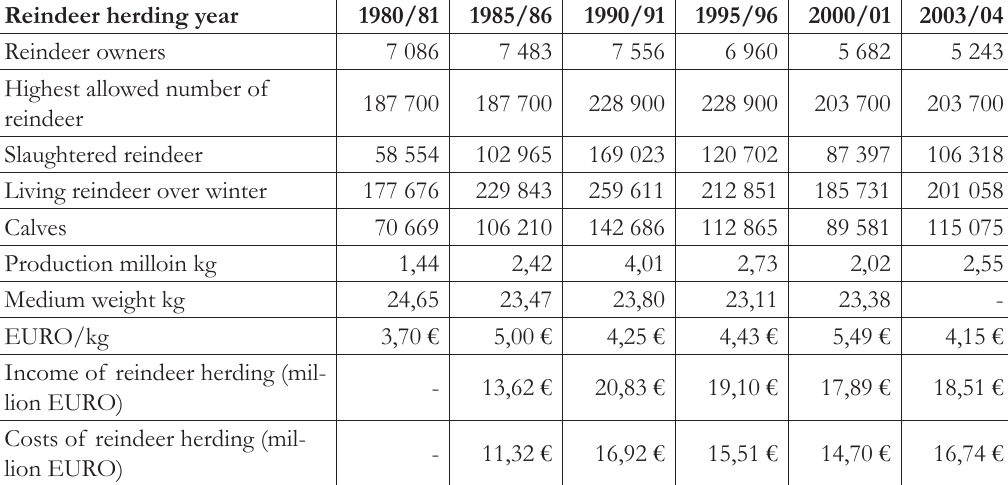
Table 1. Statistics of reindeer husbandry in Finland 1980/81 to